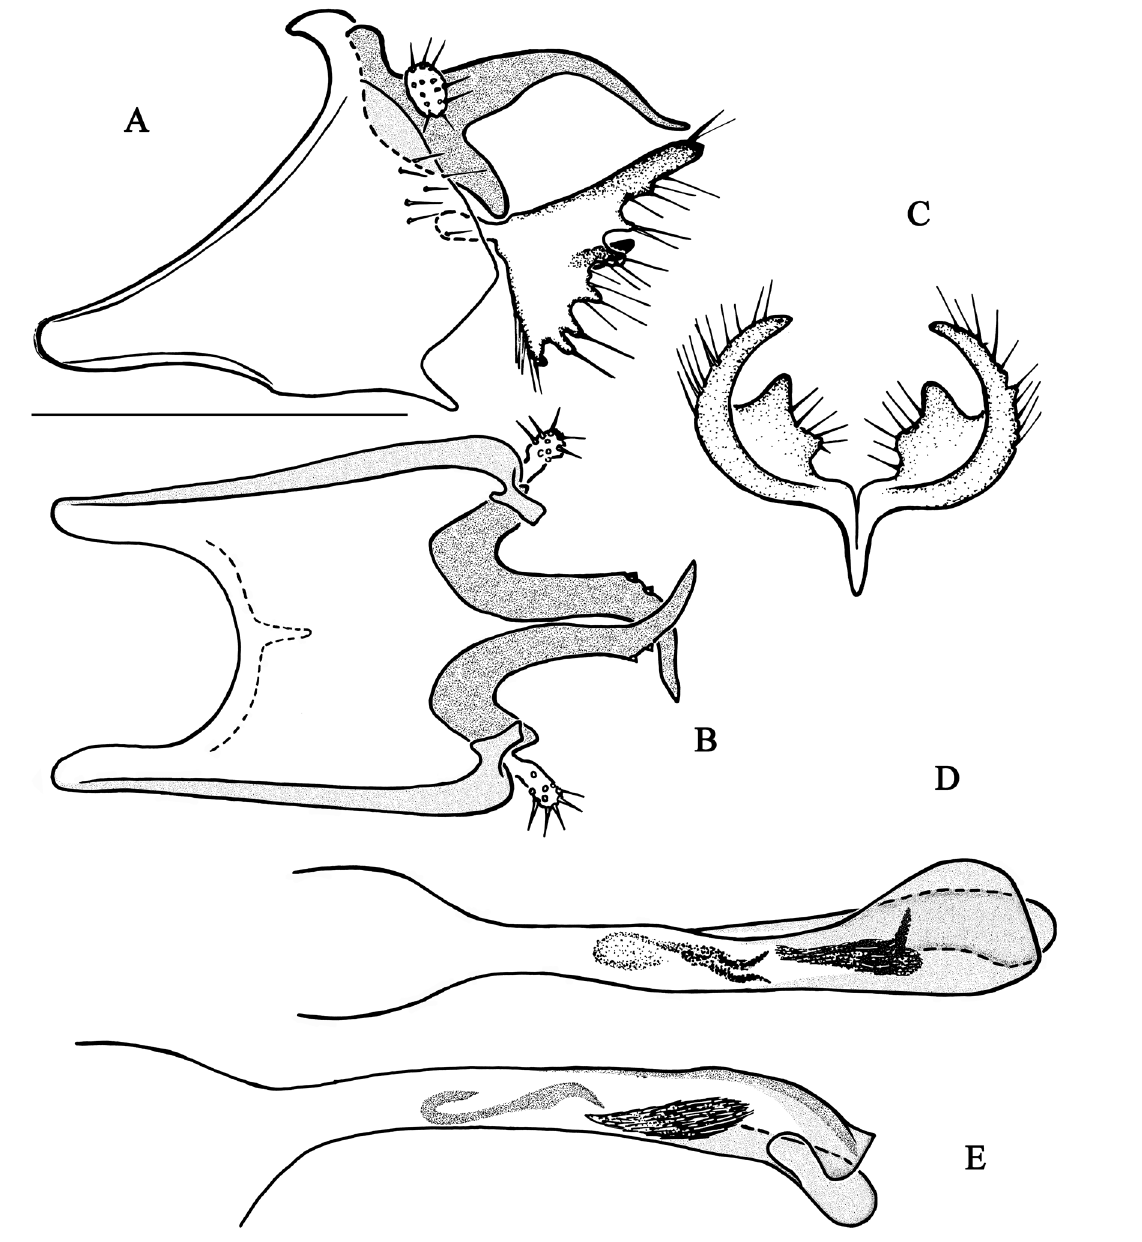
Fig. 4. Chimarra fenoevo sp. nov. A–B . Abdominal segments IX and X. A . Lateral view. B . Dorsal view. C . Inferior appendage, dorsal view. D–E . Phallic apparatus. D . Dorsal view. E . Lateral view. Scale bar = 0.5